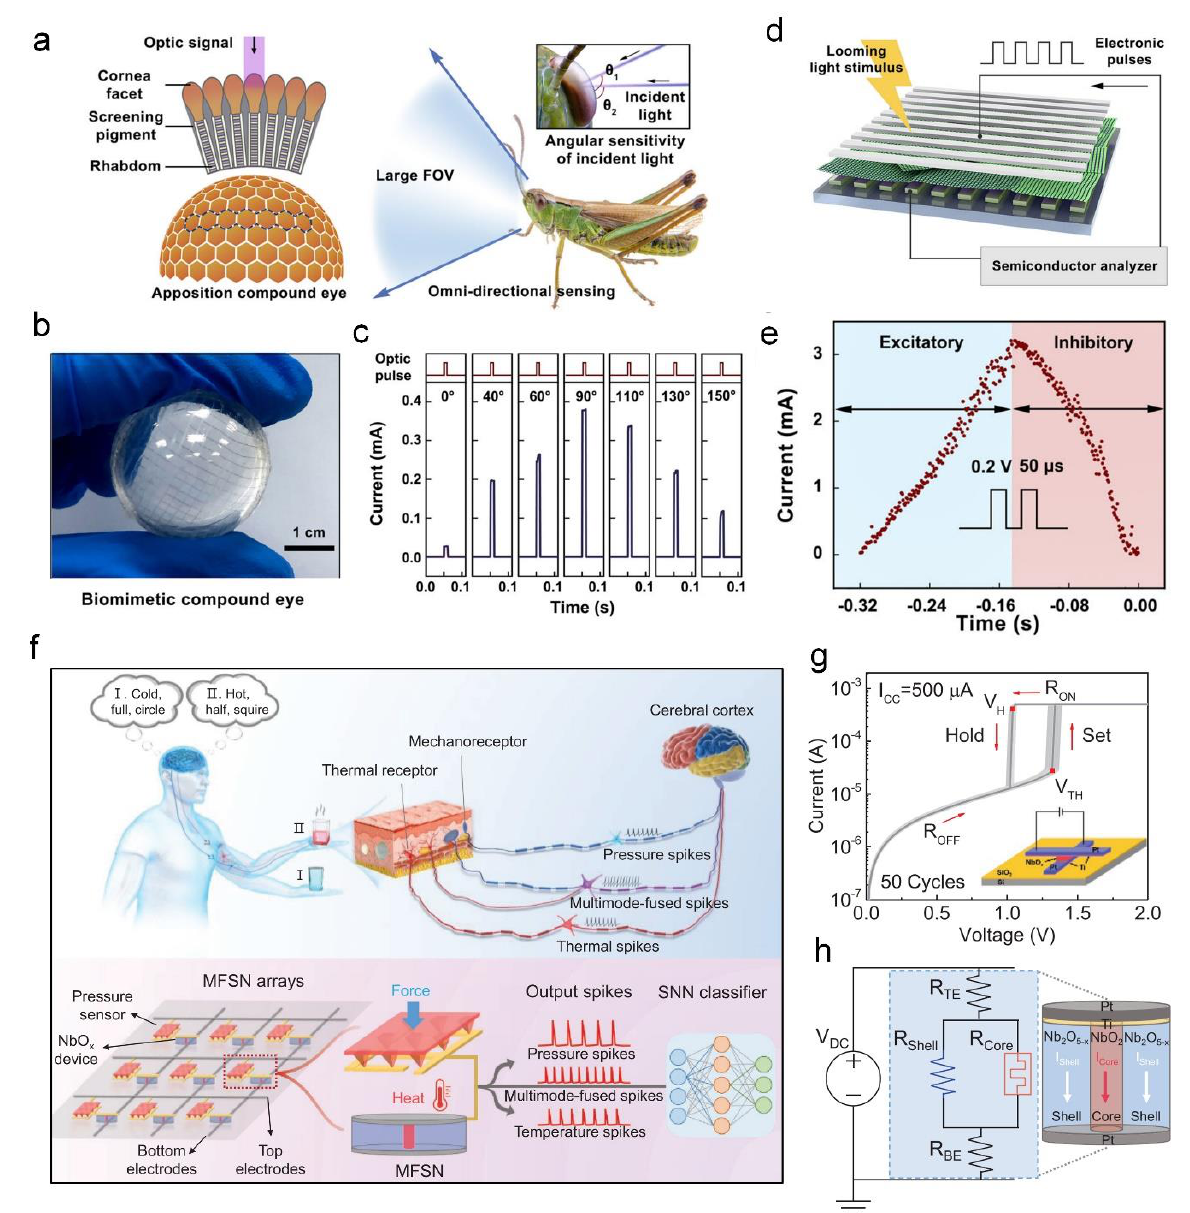
Figure 7. ( a ) Biological organization of the vision system comprising a lobula giant movement detector (LGMD) under an optical signal showing a large field of view (FoV) to detect a looming subject (visual stimulus) and predict collision with the subject. ( b ) Biomimetic compound eye for FoV detection. ( c ) Angle-sensitive response under an optic pulse (wavelength, 365 nm; power, 0.72 mW; pulse width, 10 ms) along x-axis direction by a biomimetic compound eye. ( d ) Schematic of the light- mediated TS memristor. ( e ) Excitatory and inhibitory responses of the few-layer black phosphorous nanosheet (FLBP)-CsPbBr 3 TS memristor device to a looming light stimulus with electronic pulses (voltage, 0.2 V; duration, 50 μs; interval, 50); adapted with permission from ref. [103], copyright 2021 Springer Nature. ( f ) Schematics of biological (upper) and artificial (lower) somatosensory systems. ( g ) I–V curve of an NbO x TS memristor showing uniform operation during 50 cycles. ( h ) Schematic of the core-shell of NbO x memristor with corresponding equivalent circuit model; adapted with permission from ref. [104], copyright 2022 Wiley-VCH Verlag GmbH &